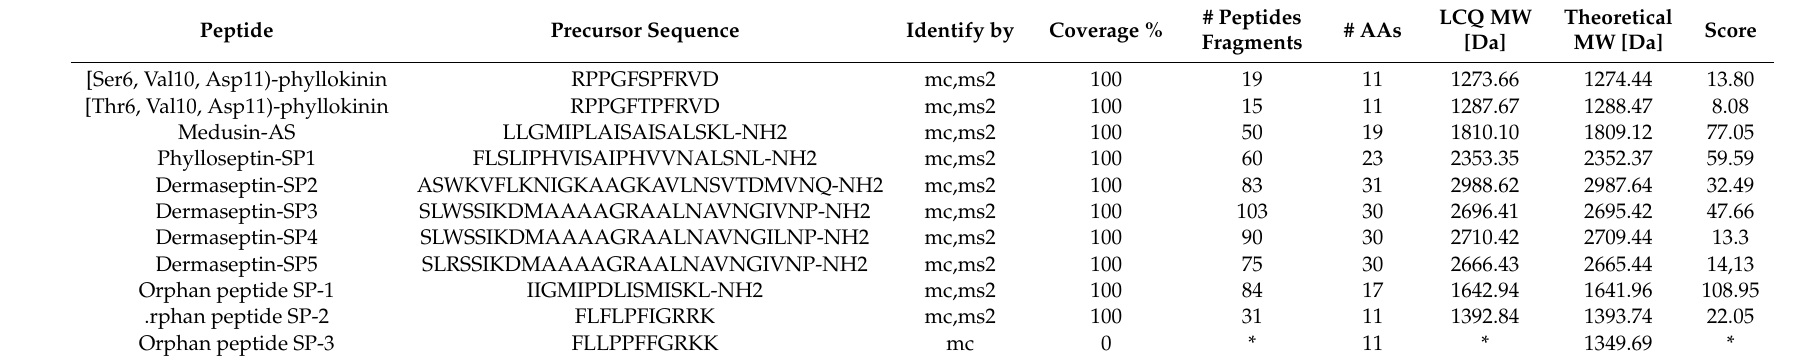
Table 1. Peptides with sequences confirmed by LCQ MS / MS